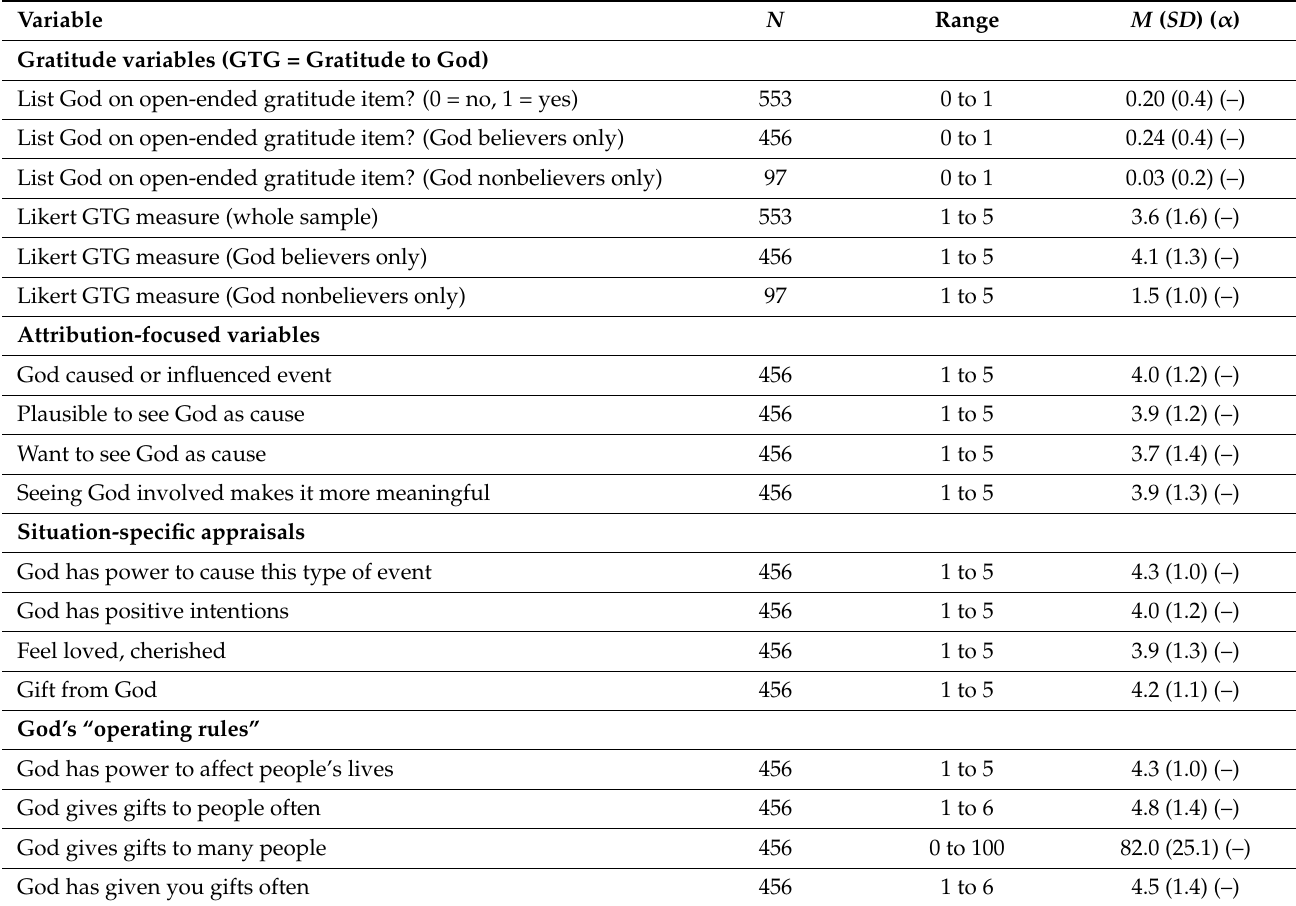
Figure 2. Likert Item on Gratitude to God: Number of Participants Endorsing Each Response. Table 1. Descriptive Statistics for Key Variables.